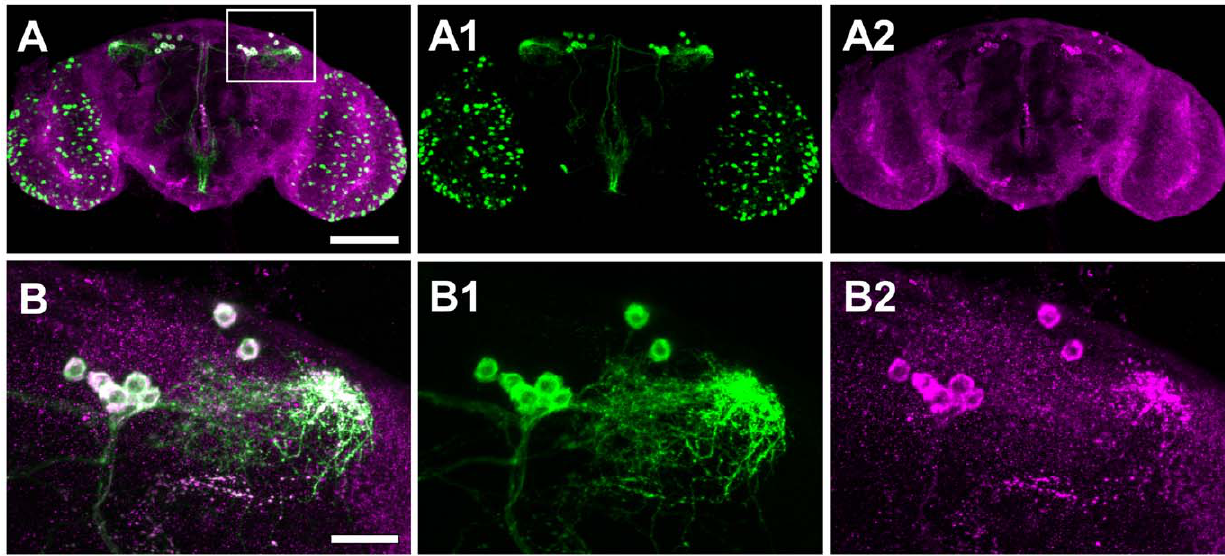
Figure 4. Drip is expressed in a neuropeptide corazonin ( Crz ) neurons located in protocerebrum of the brain. (A) Confocal sections of the brain of Crz-GL4/UAS-mCD8-EGFP female stained with anti-GFP (green, A1) and anti-Drip (magenta; A2). White indicates the overlap of these colors. Images are oriented with dorsal up. Scale bar, 100 m m. (B) Higher magnification views of the dorsolateral protocerebrum of the brain (inset box of A). Scale bar, 20 m